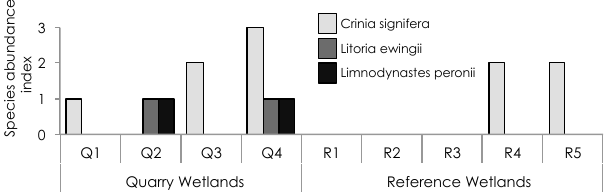
Figure 2. Abundance index for the common eastern froglet Crinia signifera , the eastern brown tree frog Litoria ewingii and the spotted marsh frog Limnodynastes peronii at quarry and reference wetlands. Abundance was estimated by categorising advertisement call inten- sity according to the index provided by Pope et al. (2000): (0) no individuals calling; (1) individual(s) can be counted with calls not overlapping; (2) calls of <15 individuals can be distinguished, but there is some overlapping; and (3) >15 individuals are